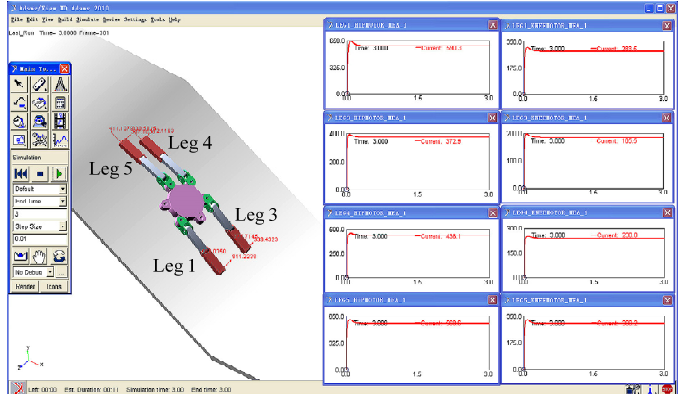
Figure 23. Simulation of static articulated torque of support phase under working condition III ‐ 2.